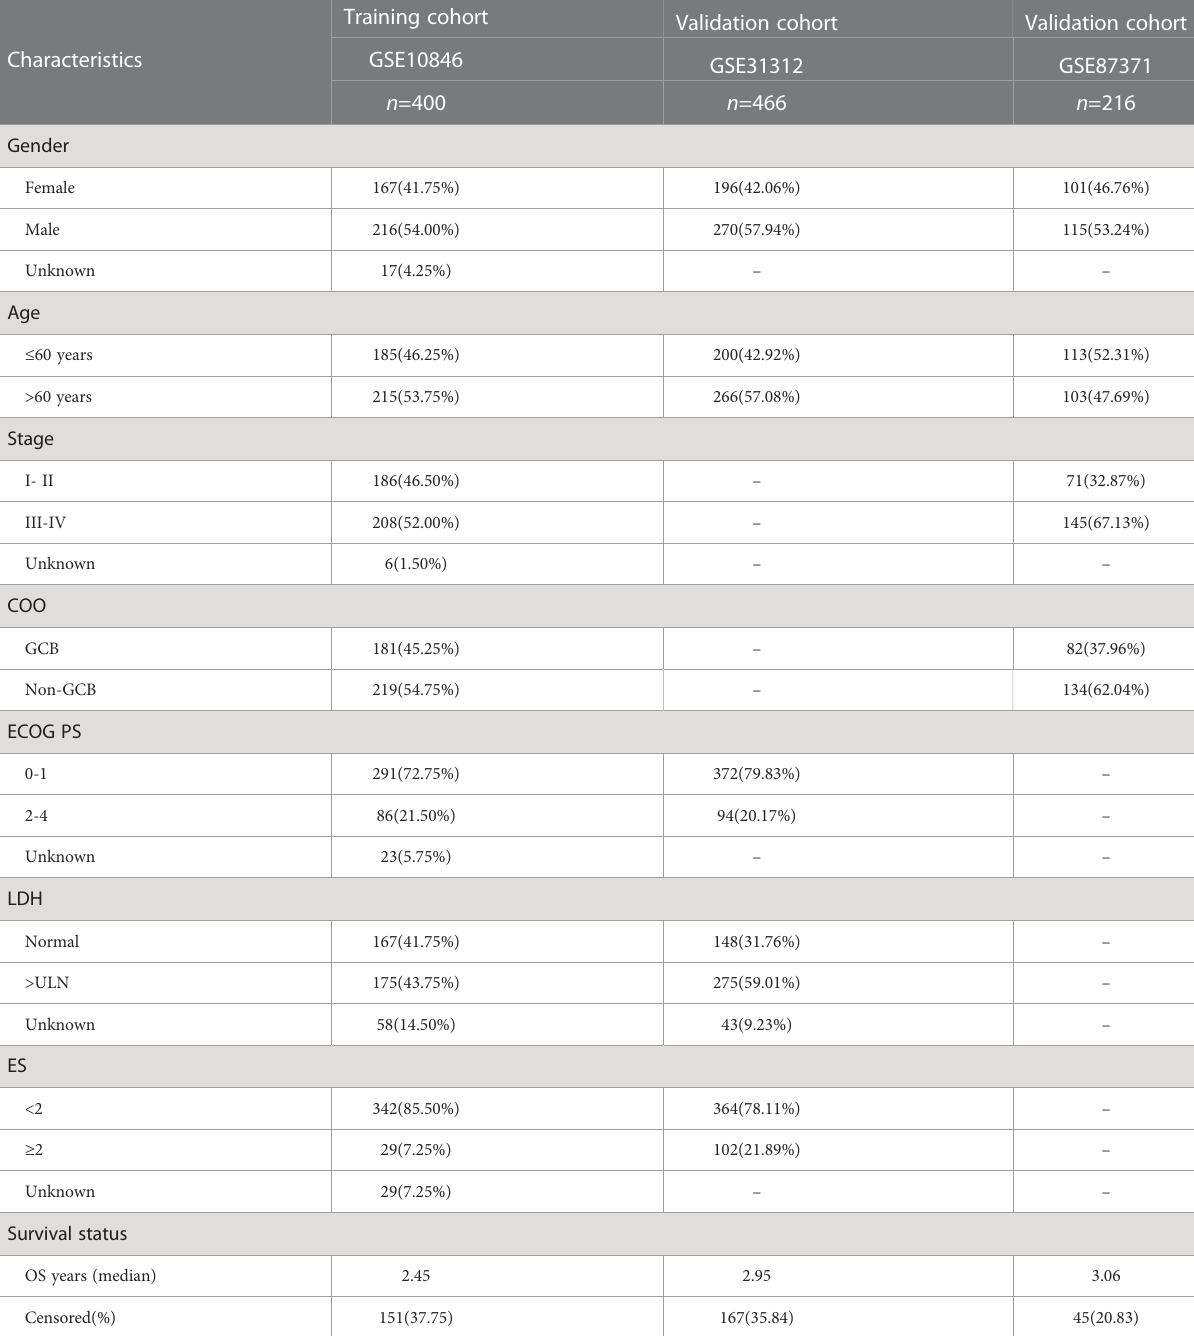
TABLE 1 The clinical characteristics of the training and validation